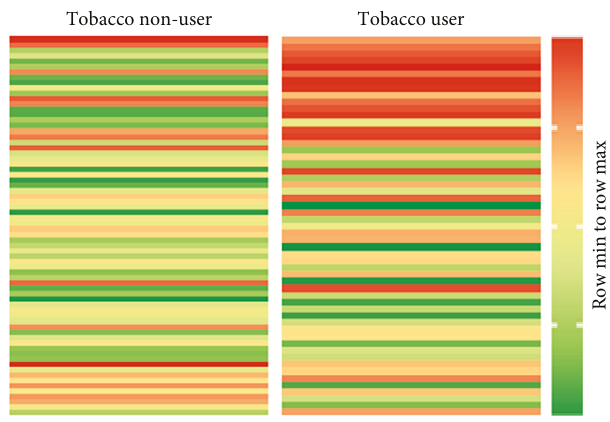
Figure 2: Heat map of RANTES according to tobacco